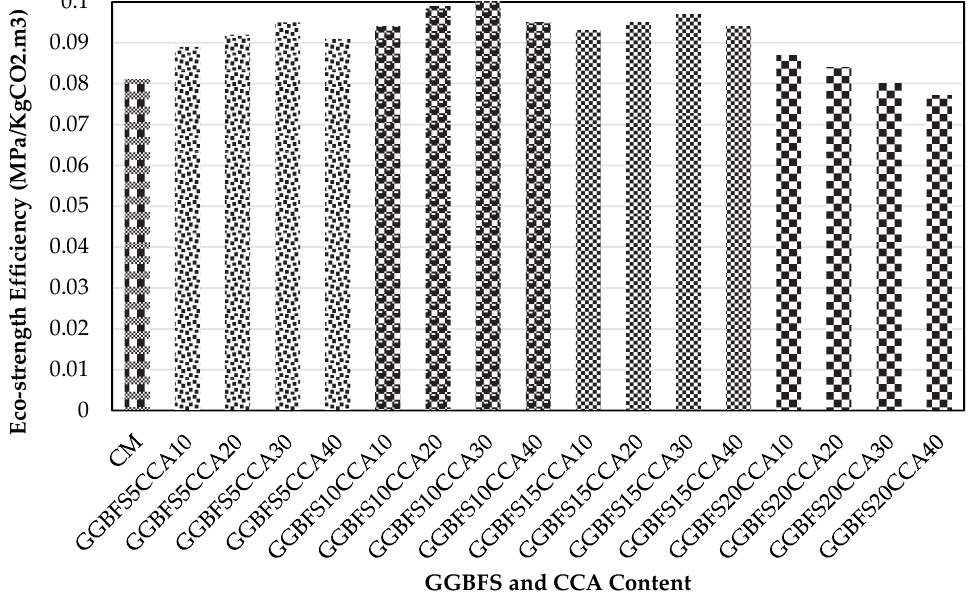
Figure 21. Eco-strength efficiency of the mixture containing GGBFS along with CCA.